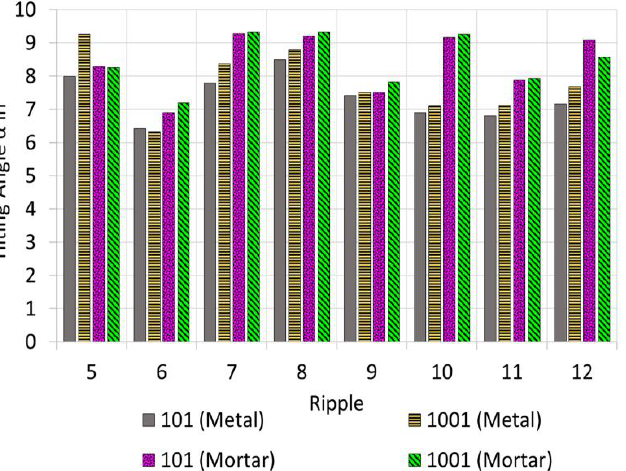
Figure 11. Tilting angles α measured on ABS parts micro injection moulded either with metal or a with mortar insert. The ABS components under investigation were shot no. 101 and no. 1001.